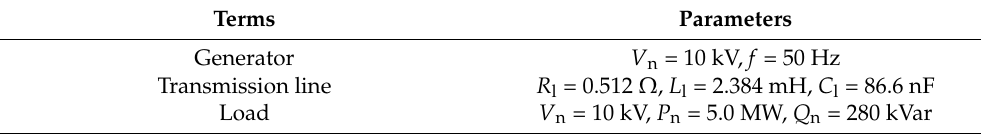
Table 1. Parameters of the simulation model.